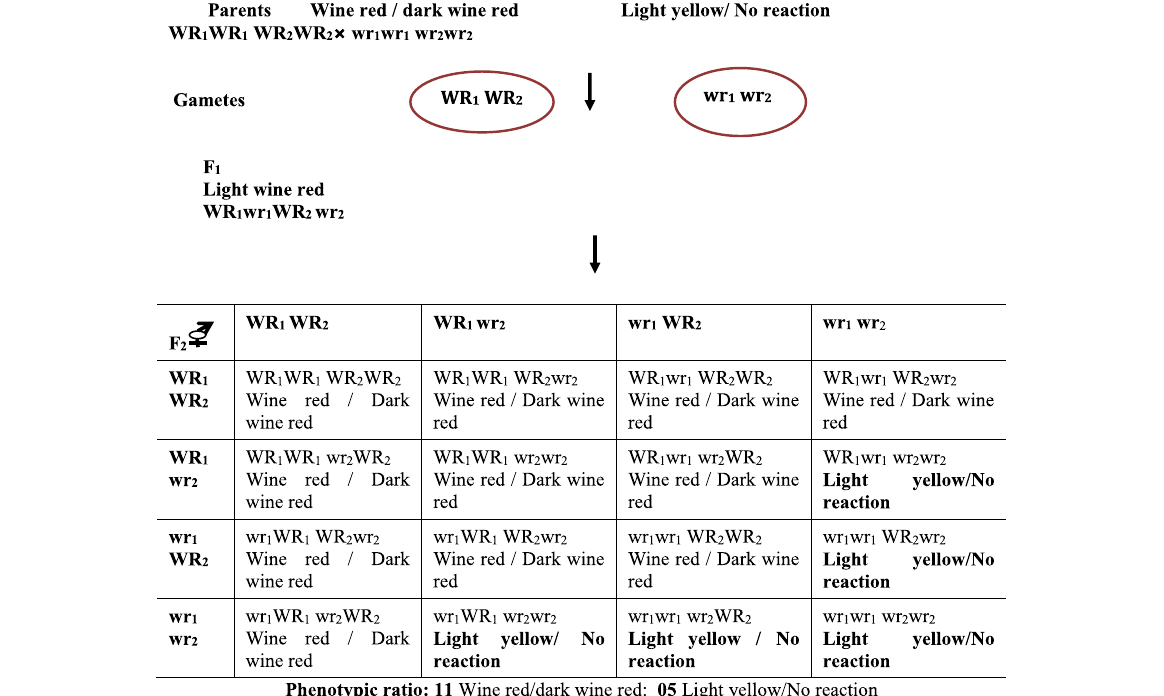
Fig. 6 Dominance modification of duplicate genes leading to a 11:5 phenotypic ratio in the F 2 progenies for the presence of wine red / dark wine red and light yellow/no reaction colouration of aleurone layer of rice seed with NaOH and KOH